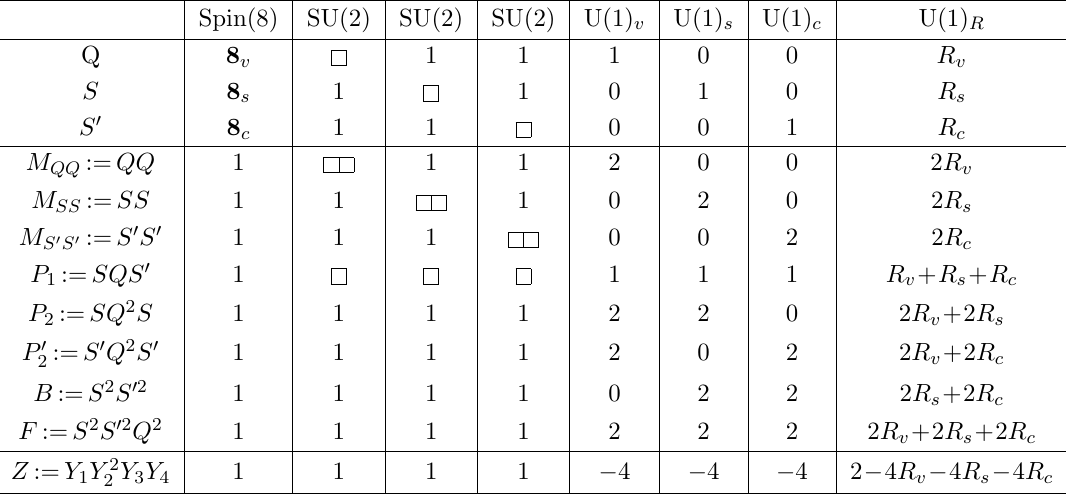
Table 6 . 3d N = 2 Spin(8) theory with ( N v ;N s ;N c ) = (2 ; 2 ;